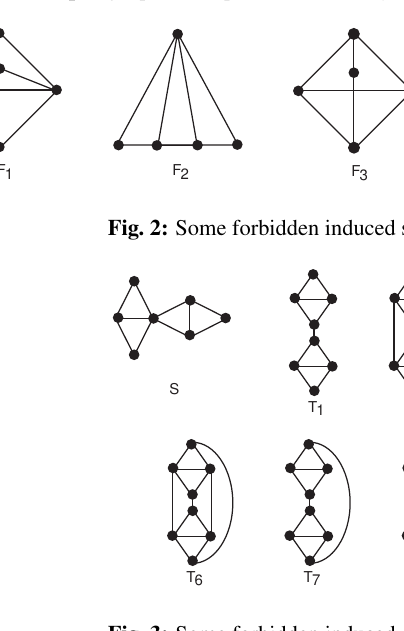
Fig. 3: Some forbidden induced subgraphs for probe diamond-free